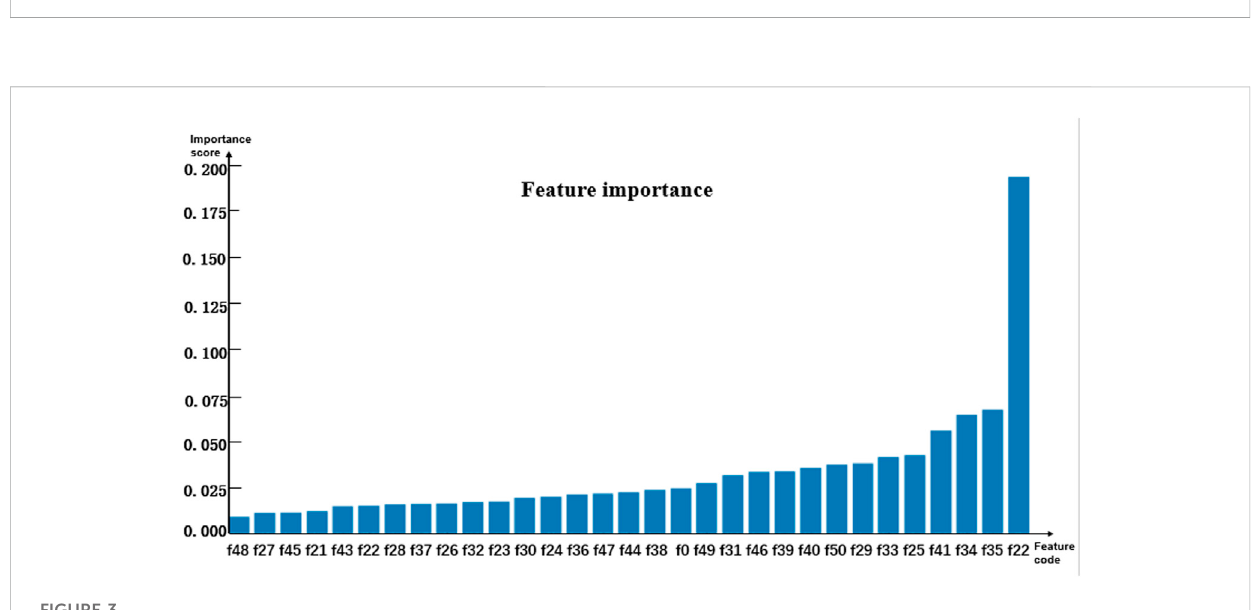
FIGURE 3 Histogram showing the importance of parameters in model